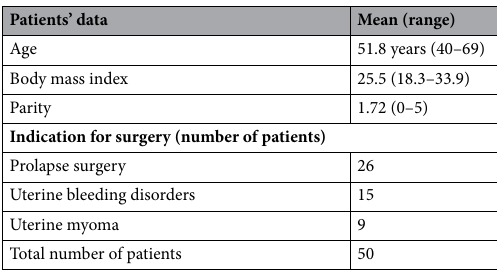
Table 2. Baseline characteristics of